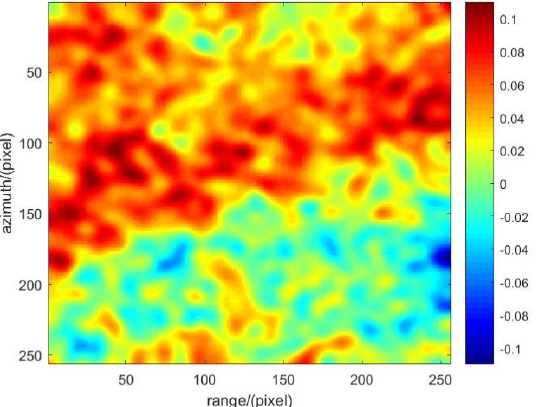
Figure 20. The extracted interferometric phase from the Gaofen − 3 along − track InSAR data after 1024 multi − looks and three times 10*10 element boxcar averaging (size: 256(azimuth)*256(range)).